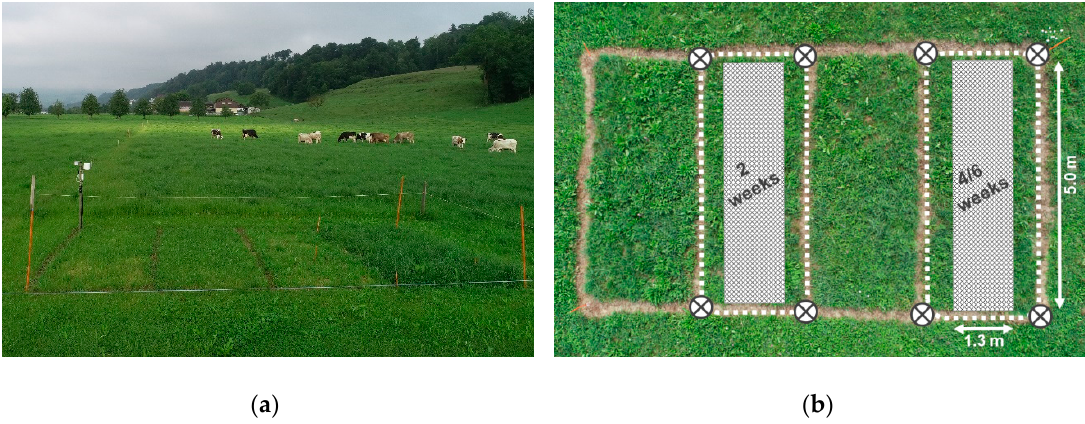
Figure 2. Selected experimental plot, shown as ( a ) front view and ( b ) aerial view, where the dashed lines indicate the two subplots. The sampling areas are highlighted with a checkered pattern. The age of the herbage at sampling was two weeks (left subplot) and four to six weeks (right subplot). The ground control points are highlighted as crossed circles.